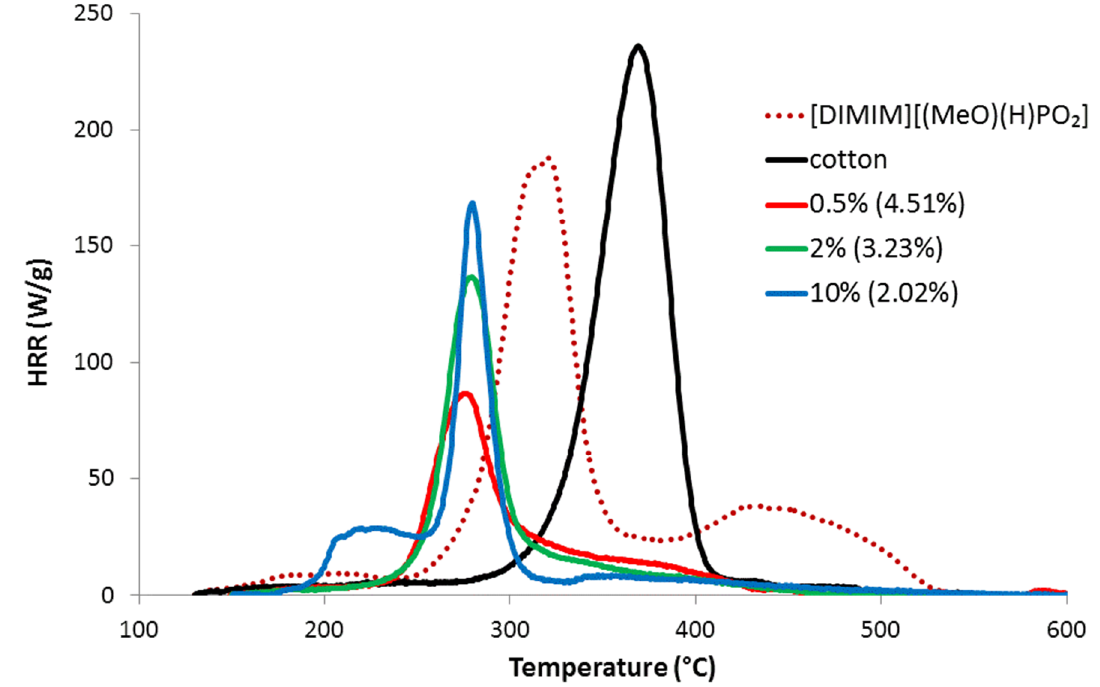
Figure 7. HRR versus temperature curves for [DIMIM][(MeO)(H)PO 2 ], raw cotton and for regenerated cellulose obtained from the dissolution of various contents of cotton into [DIMIM][(MeO)(H)PO 2 ] (in brackets, phosphorus contents from ICP-AES).